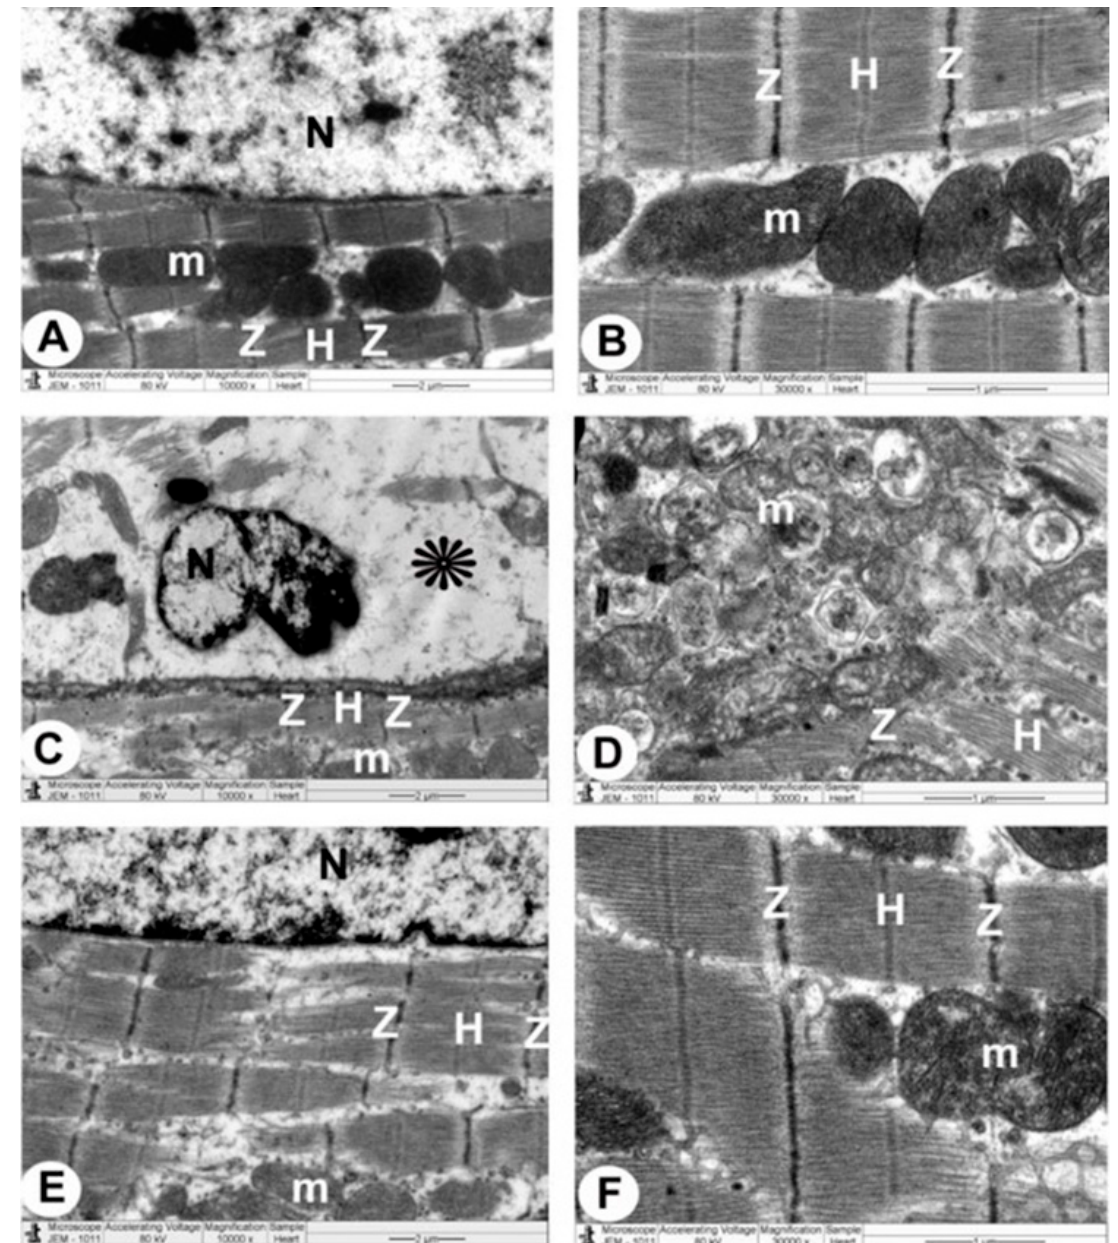
Figure 3. TEM micrographs of cardiac architecture from all groups. The control group ( A , B ) show a normal myocardial striation architecture with well-preserved mitochondrial (m) integrity. Preserved nucleus (N) with a normally distributed chromatin and nuclear envelope, abundant cytoplasm packed with intact myofibrils and a striated pattern with obvious (Z and H) bands can be noticed. Endotoxin group ( C , D ) exhibits swollen mitochondria (m) with disorganized cristae with flocculent density deposition, defects in the outer mitochondrial membrane, and disrupted myofibrils with disarrangement of muscle (Z and H) bands. Disassembly of the nuclear envelope, random dispersion of clumped chromatin in nuclei (N) and marked spaces interstitially (*) interstitially are also observed. Endotoxin plus Vit C group ( E , F ) demonstrates a typical architecture with well-preserved integrity and a striated pattern of clear (Z and H) bands, nucleus (N) with proper chromatin organization, and nuclear envelope and sustained mitochondria (m).